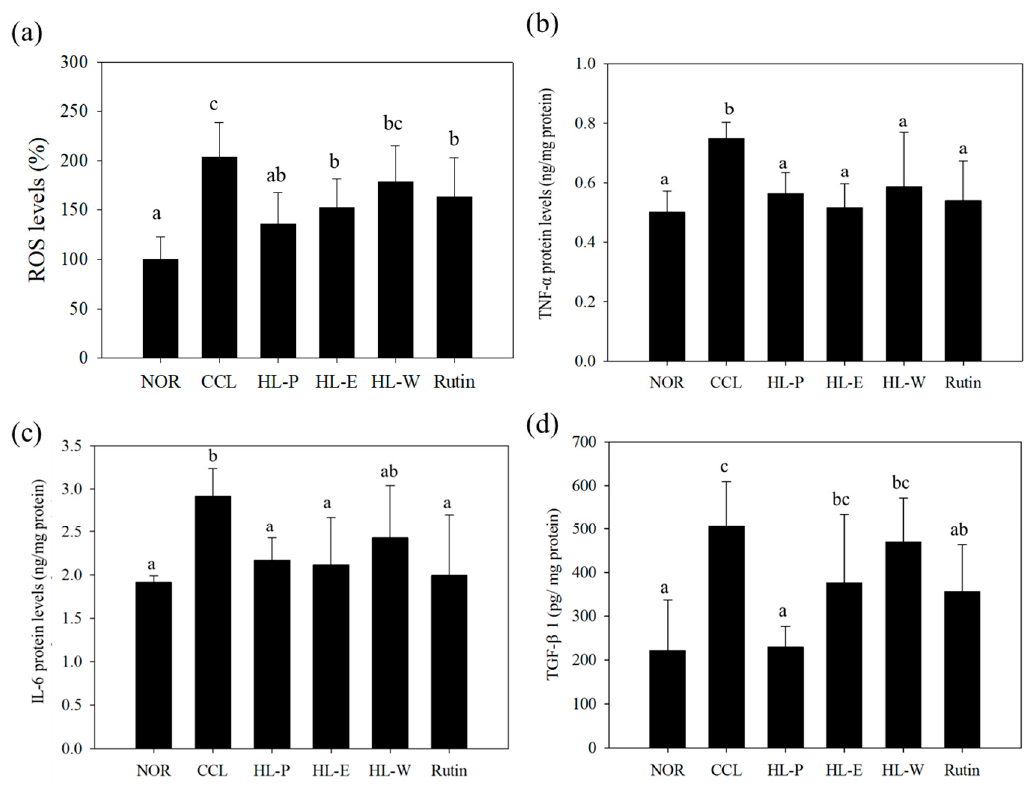
Figure 5. The effects of red quinoa and its extracts on ROS ( a ), TNF- α ( b ), IL-6 ( c ), and TGF- β 1 ( d ) of CCl 4 -induced liver injury mice. TNF- α and IL-6 protein levels were measured using an indirect ELISA method. NOR: normal group, CCL: CCl 4 -induced liver injury mice, HL-P: CCl 4 -induced liver injury mice fed 5.13 g/kg (rutin 8.46 mg/kg) of red quinoa-powder, HL-E: CCl 4 -induced liver injury mice fed 1.54 g/kg (rutin 16.4 mg/kg) of red quinoa-ethanol extracts, HL-W: CCl 4 -induced liver injury mice fed 1.54 g/kg (rutin 3.92 mg/kg) of red quinoa-water extracts, Rutin: CCl 4 -induced liver injury mice fed 16.4 mg/kg of rutin. Data are presented as mean ± SD ( n = 6). a,b,c Different letters indicate significantly different values according to a one-way ANOVA using Duncan’s multiple test ( p < 0.05).